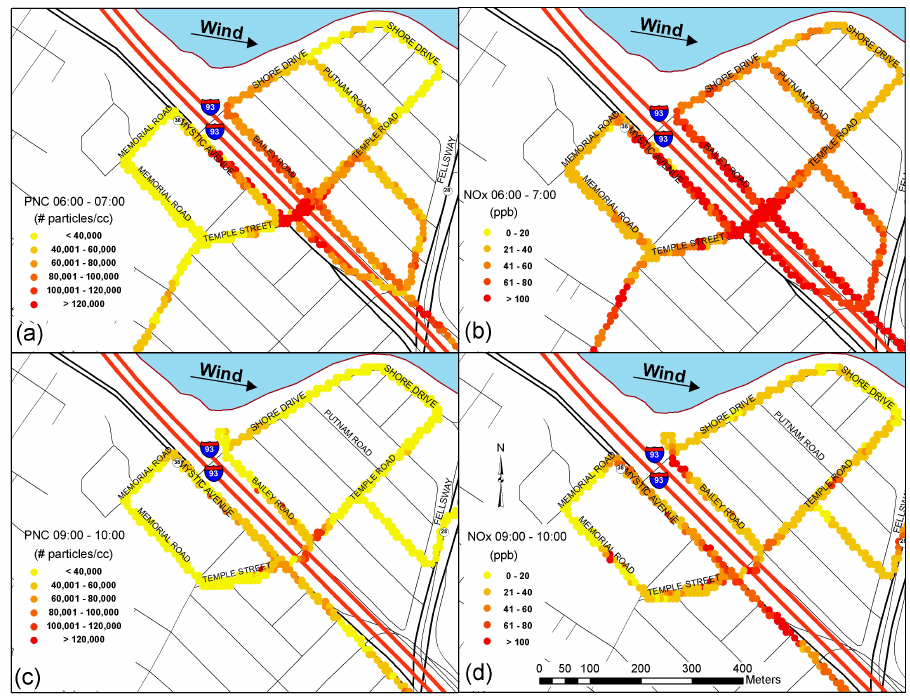
Fig. 8. Spatial distribution of particle number concentration (7–1000nm) ( a and c ) and NO x concentration ( b and d ) measured between 06:00–07:00 and between